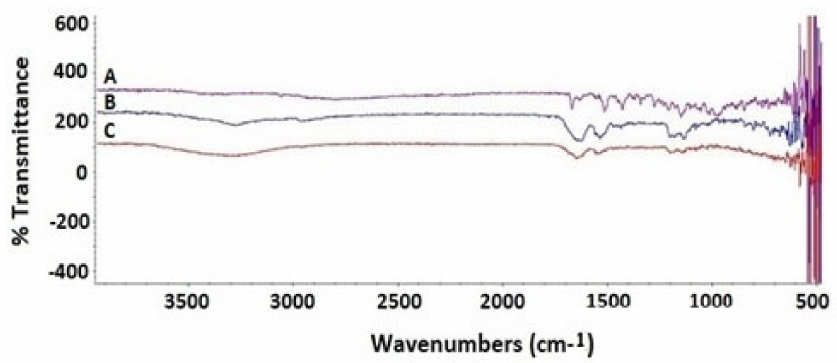
Figure 4. FTIR spectra of SIT ( A ), MEL ( B ) and combination of SIT-MEL ( C